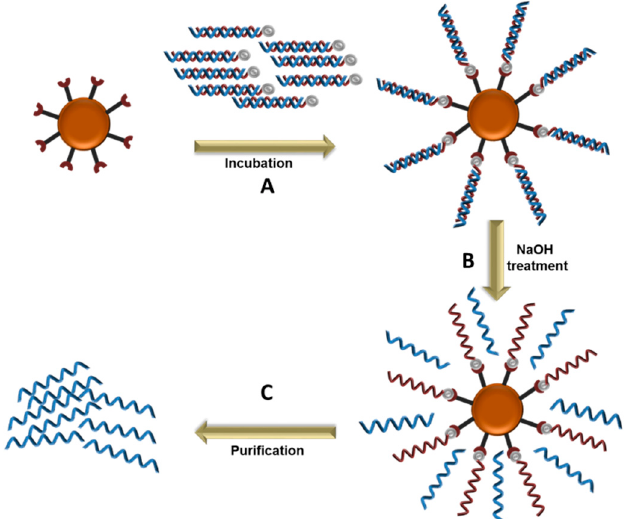
Figure 2. DNA strand separation using magnetic beads. A . Immobilization of the double stranded sequences on the magnetic beads; B . Denaturation of the double stranded DNA by NaOH treatment; C . Purification of the unbound sequences.